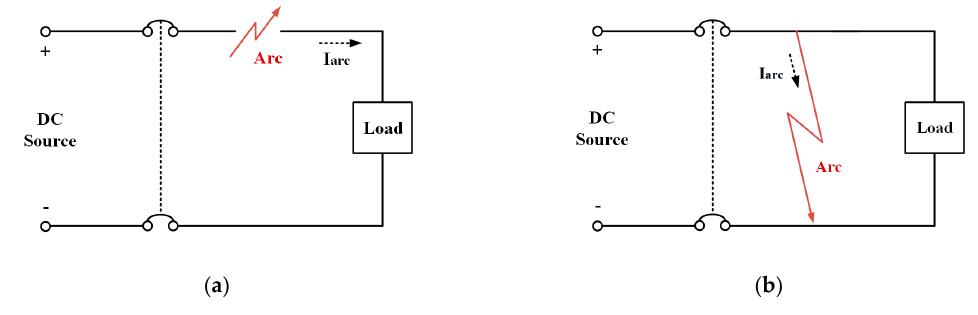
Figure 2. Types of arc faults. ( a ) series arc; ( b ) parallel arc.